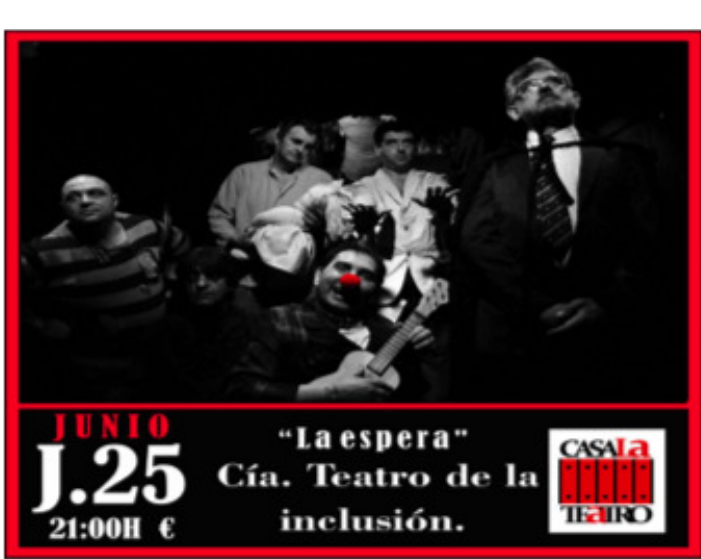
Figure 3. A scene from Se Comparte Mundo in 2012.